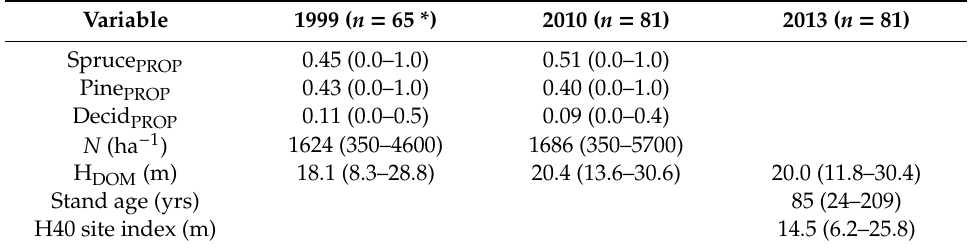
Table 1. Mean values and ranges of field-observed variables in 1999, 2010, and 2013.